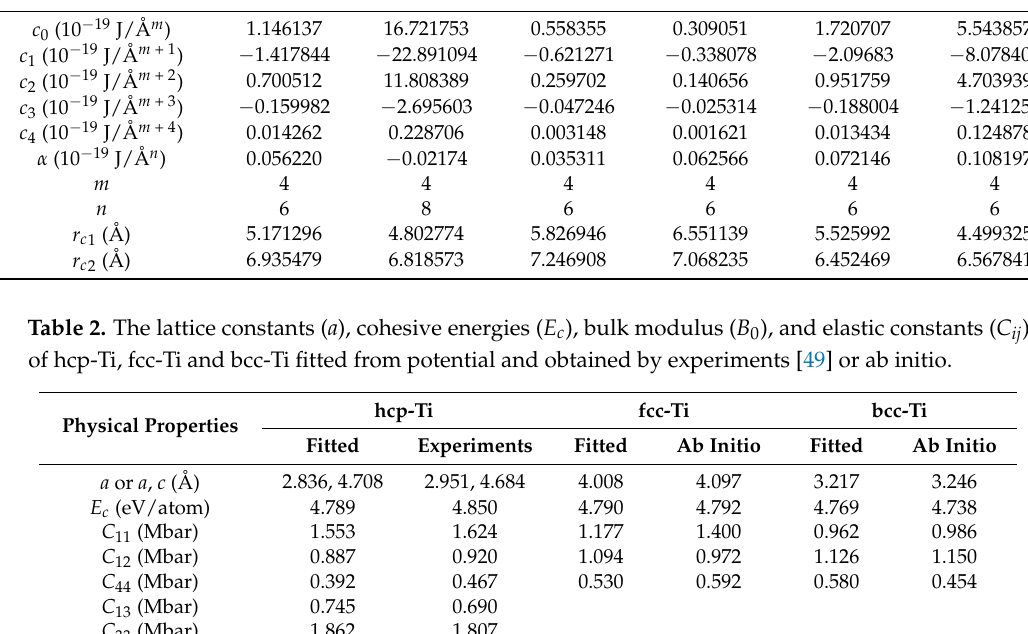
Table 1. The potential parameters for the Ti-Nb-Al system. Potential Parameters